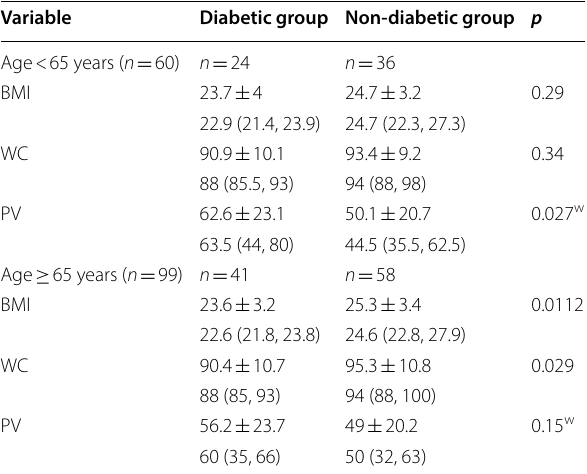
Table 2 Comparison of anthropometric parameters and prostate volume between diabetic and non-diabetic patients according to age distribution